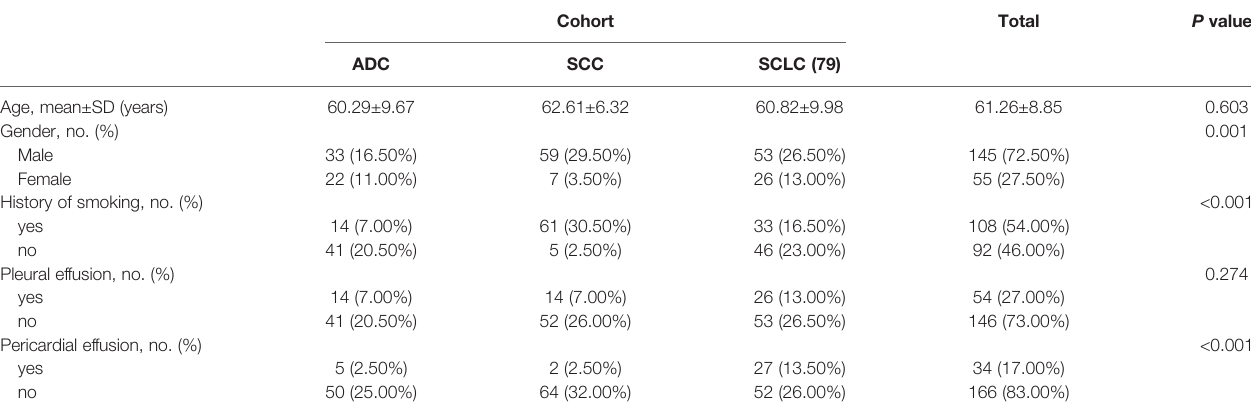
TABLE 1 | Summary of the patient data in our